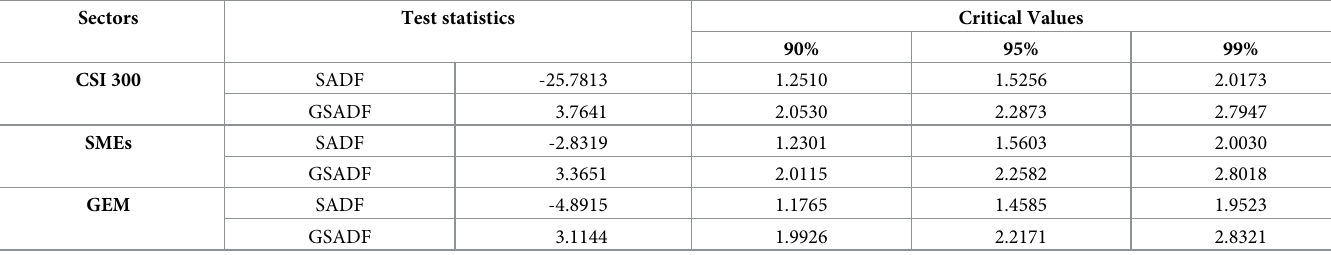
Table 1. Results for SADF and GSADF test on ln( p )/ln( d ) of CSI 300, SMEs and GEM. Sectors